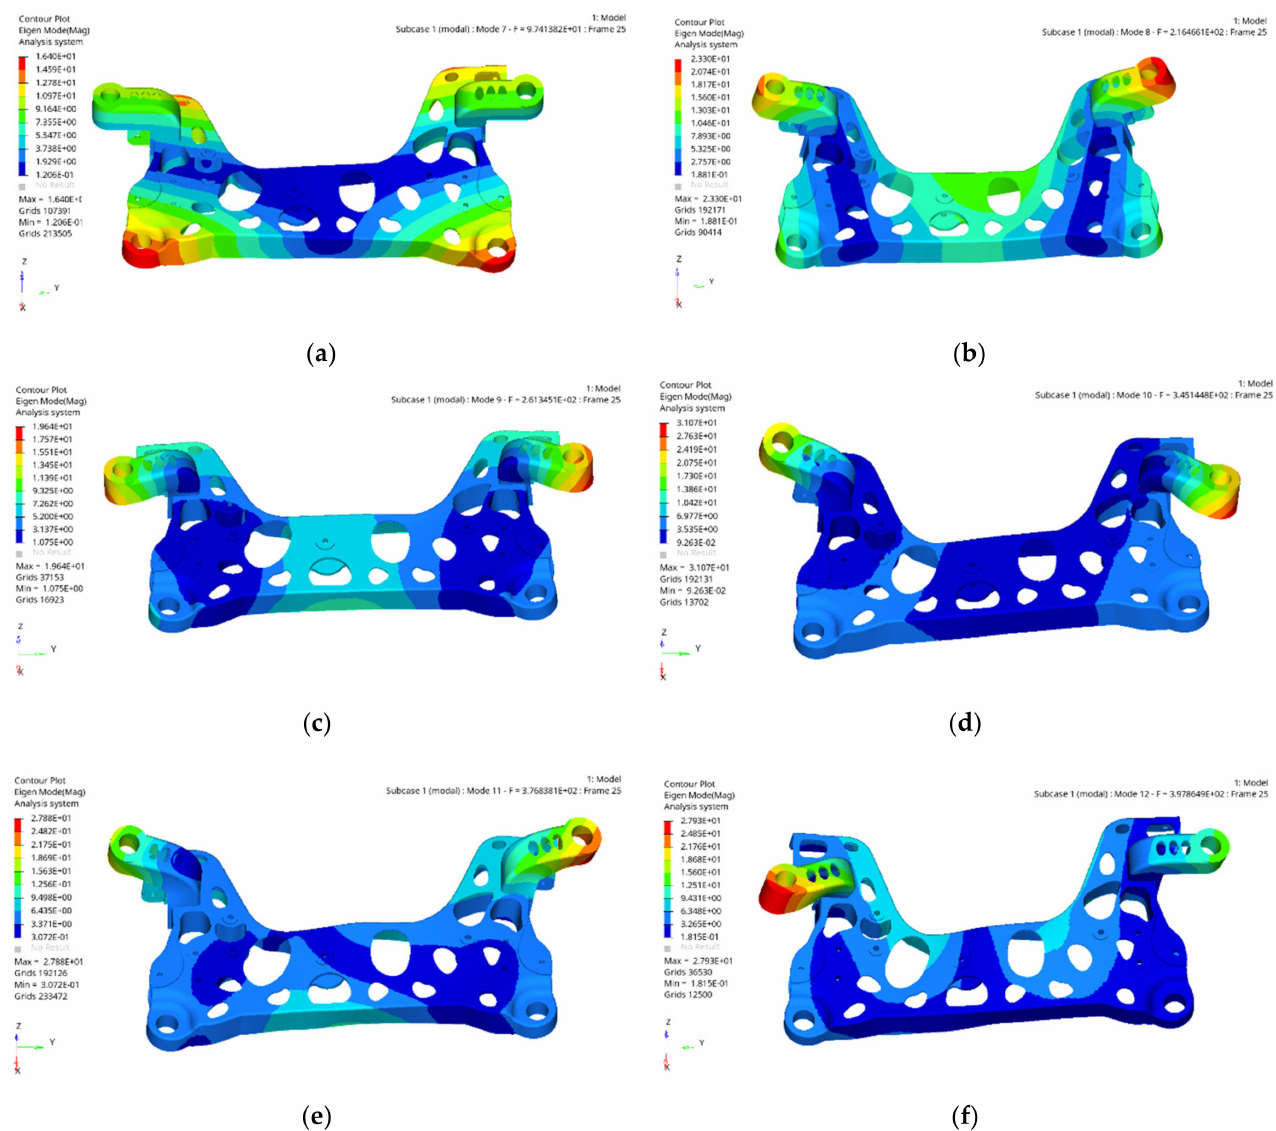
Figure 6. Non-rigid body modal shapes for the front 6th order of aluminium alloy front subframe. ( a ) First order modal shape. ( b ) Second order modal shape. ( c ) Third modal shape. ( d ) Fourth modal shape. ( e ) Fifth modal shape. ( f ) Sixth modal